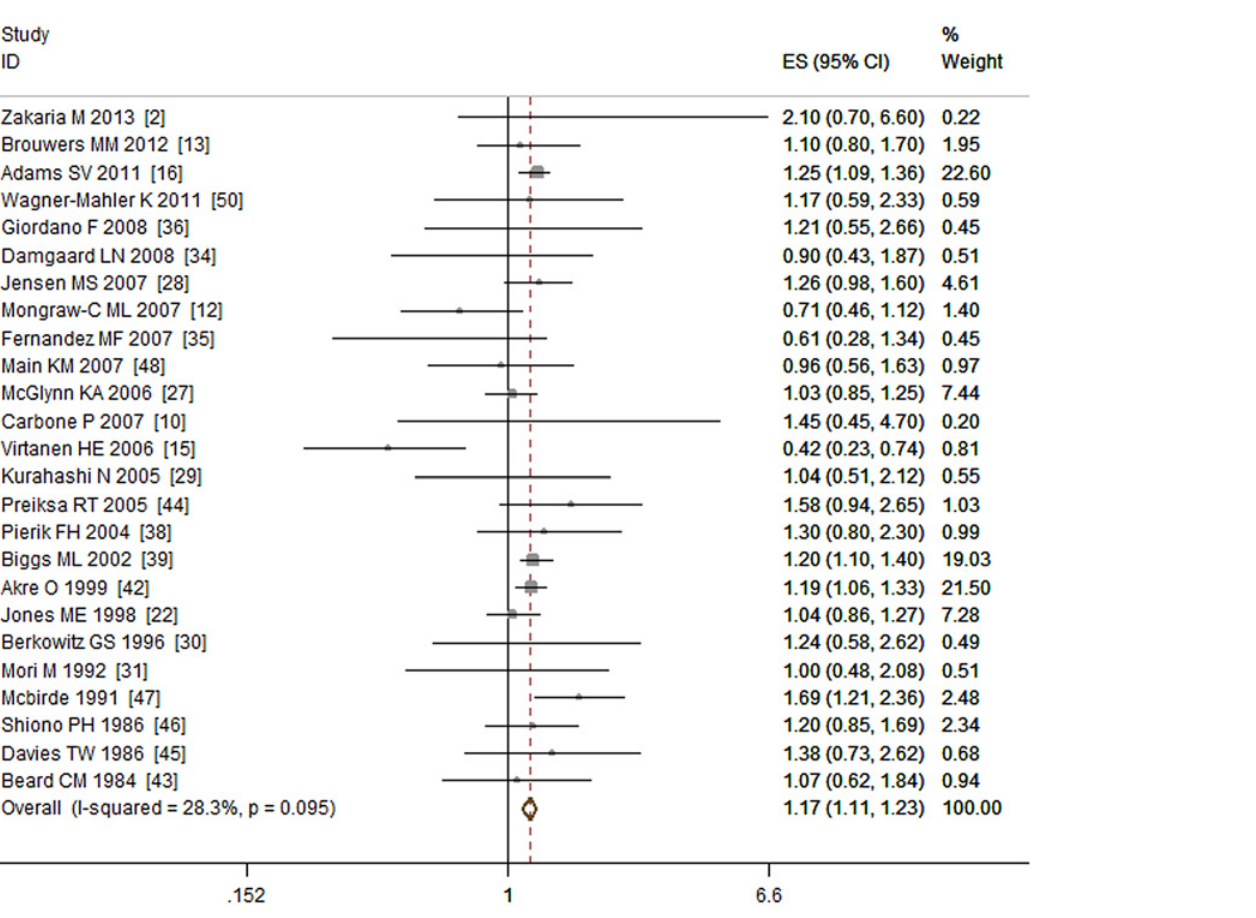
Fig 2. Forest plot for maternal gestational smoking and risk of